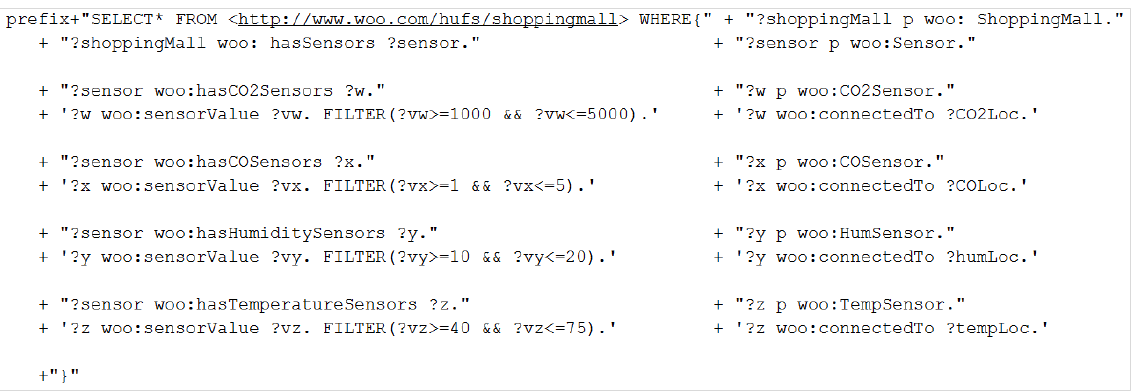
Figure 26. Class expressions into SPARQL